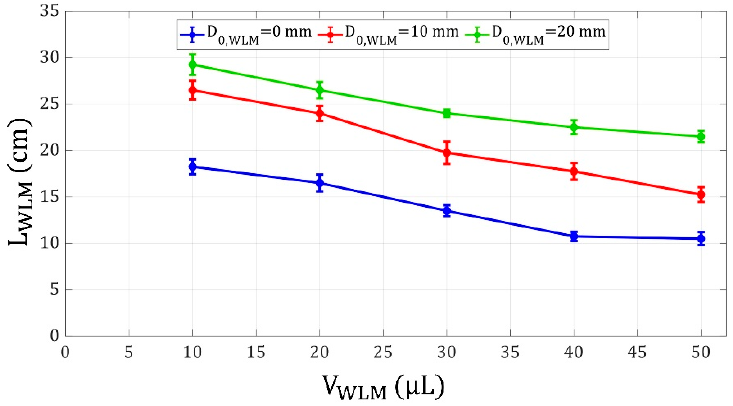
Figure 8. WLM shooting distance versus WLM volume for WLM initial distances of 0, 10, and 20 mm from the electromagnet, FLM volume and initial distance of 30 μ L and 30 mm from the electromagnet, respectively, and the coil current of 3 A.